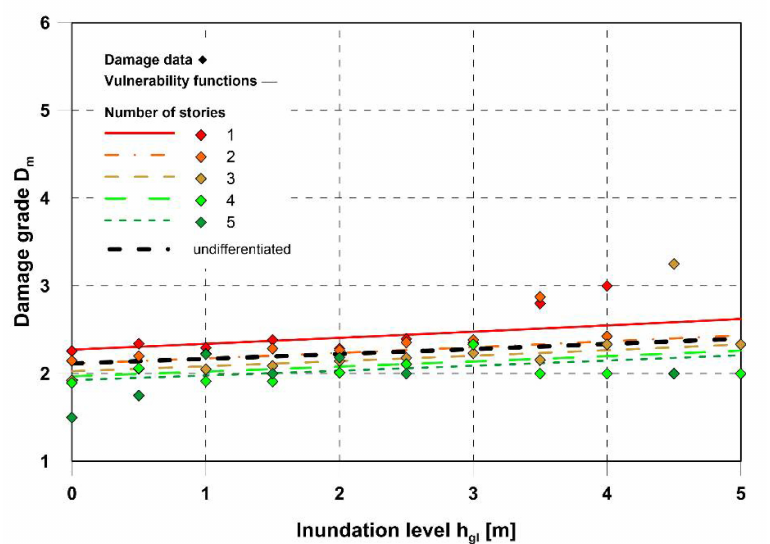
Figure 8. Damage data and simplified vulnerability functions for HW-C considering the inundation level above ground level ( h gl ) and the number of storeys ( n st ) (taken from